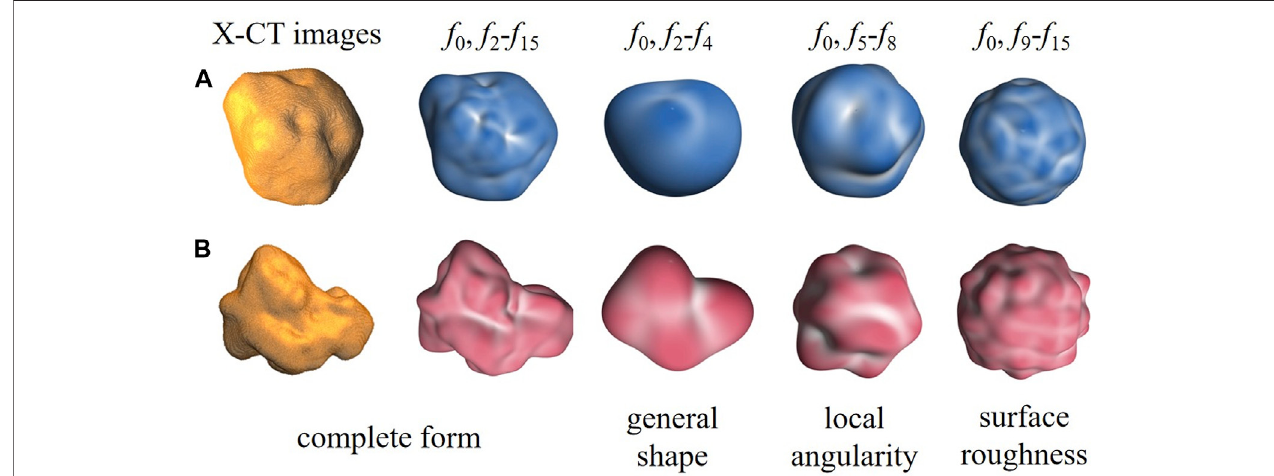
FIGURE 2 | SH reconstructions of a typical CS particle and a typical FS particle by accumulating harmonics in different scopes of SH frequency spaces (A) the typicalCSparticle, (B) thetypicalFSparticle.ThecolumnsfromlefttorightareX-CTimages,SHreconsturctionat